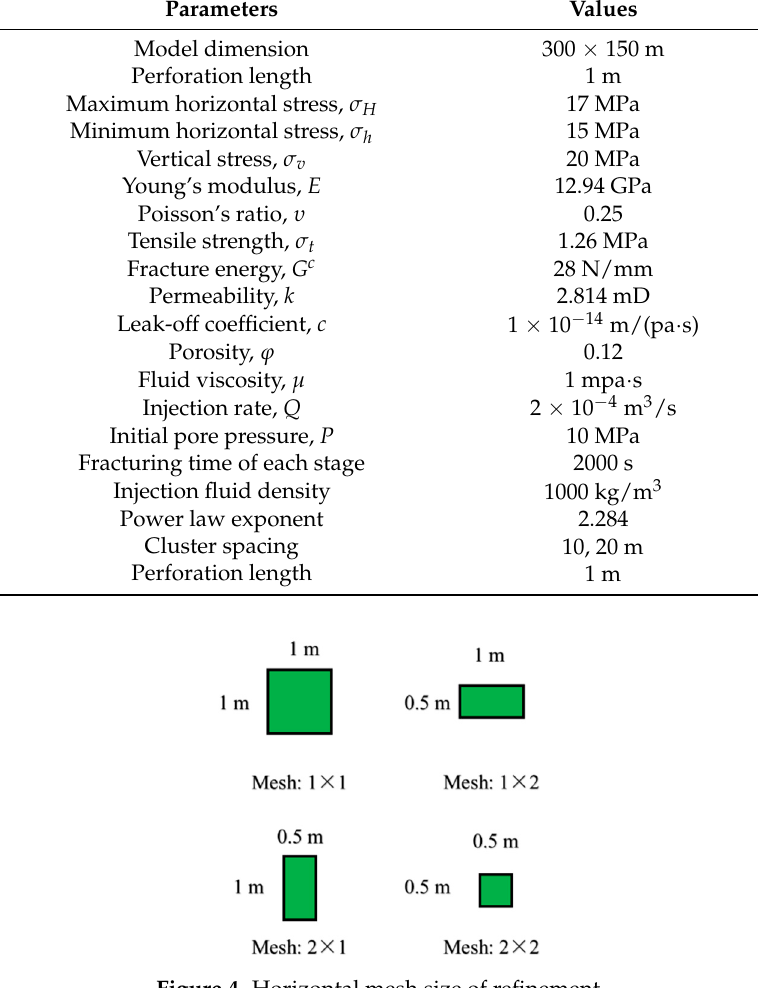
Table 1. Input parameters of simulations.